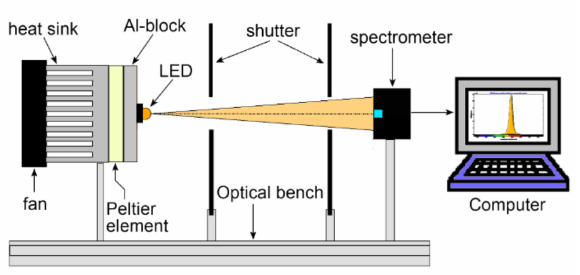
Figure 12. Outline of the measurement